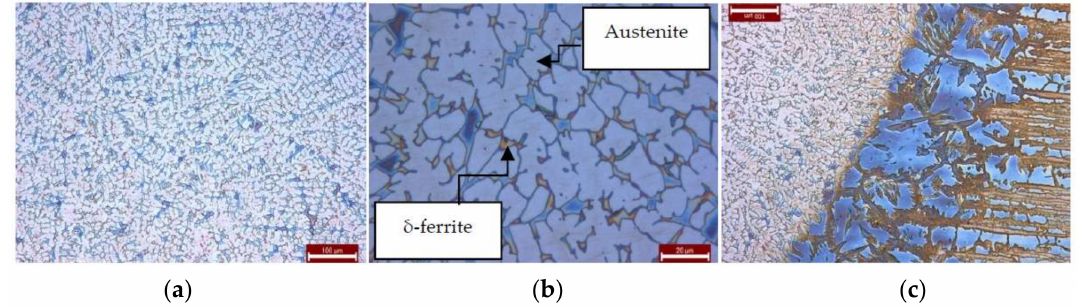
Figure 8. Micrographs of weldments by Ar + 9% N 2 shielding gas ( a ) weld metal 100 × ( b ) weld metal 500 × ( c ) HAZ 100 ×